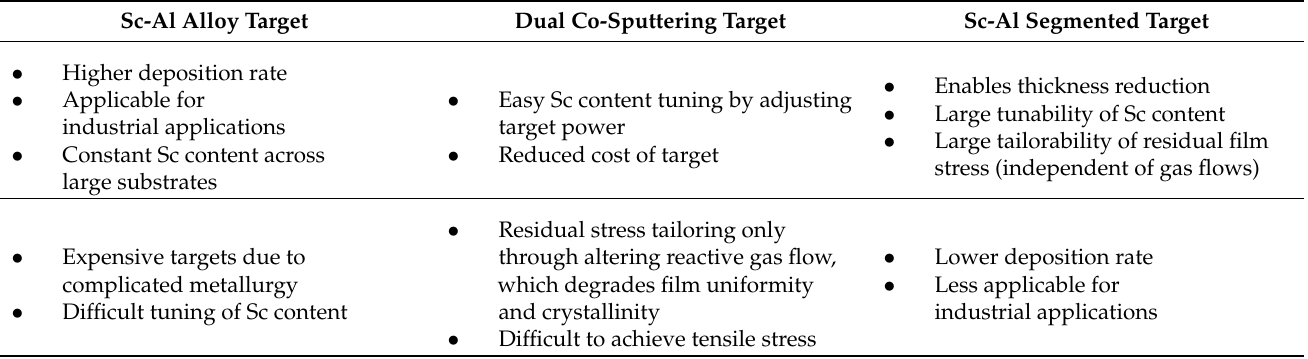
Table 4. Comparison of various target